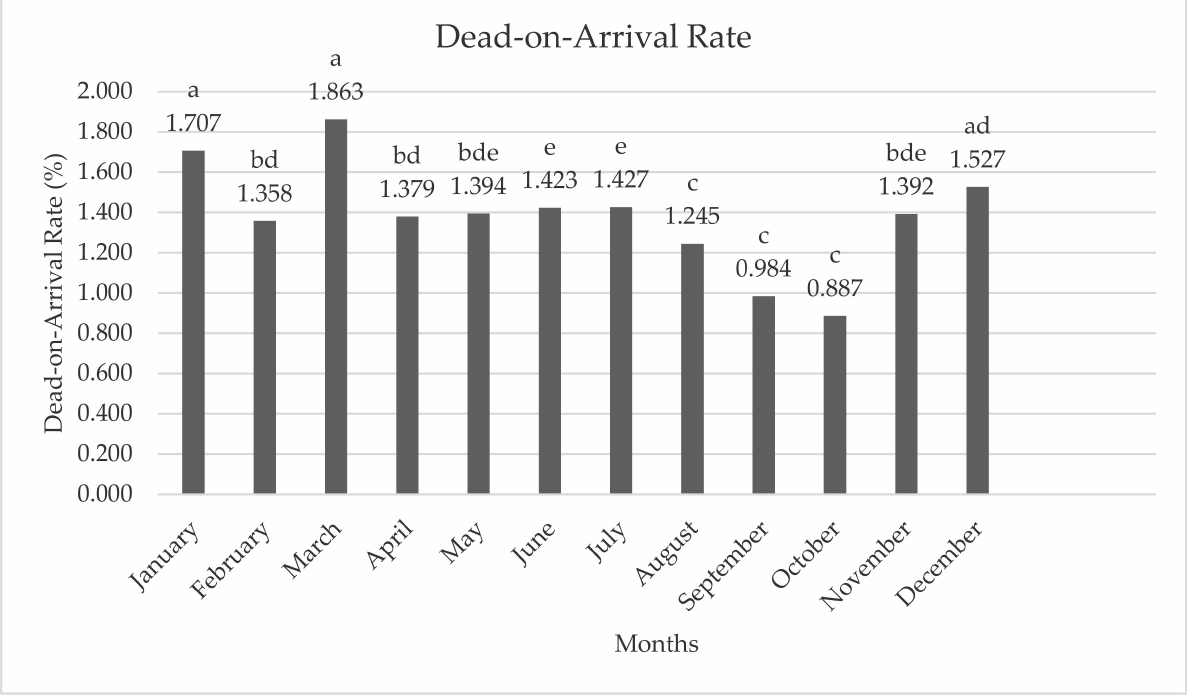
Figure 3. Average dead-on-arrival rate of hens according to months. a – d ; different letters indicate statistical